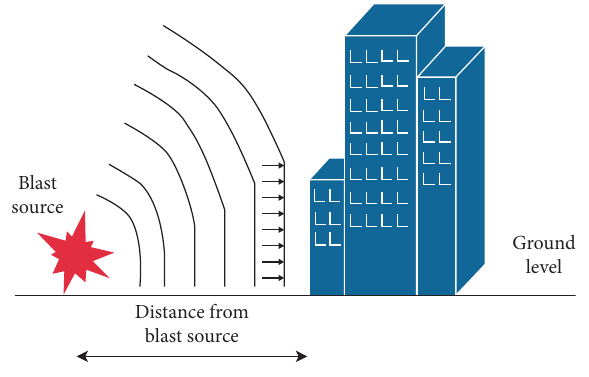
Figure 6: Blast load on buildings